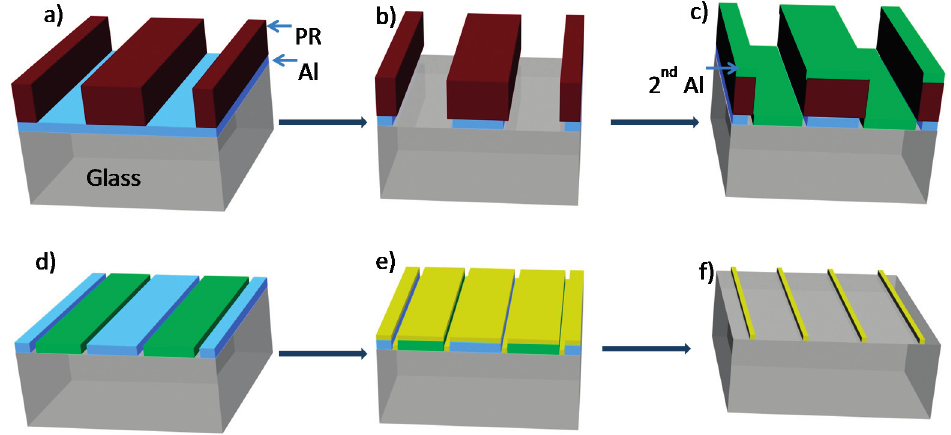
Figure 1. “Edge-patterning” of a thin aluminum film to realize nano- and micron-sized gap and wires. The process starts via photoresist (PR) patterning ( a ); isotropic etch to realize Al undercut ( b ); evaporation of a 2nd Al layer ( c ); followed by photoresist lift-off to realize nano- and micron-sized gaps ( d ); Nano- and micron-sized wires are subsequently formed by depositing a higher work function metal onto the gaps ( e ); followed by aluminum lift-off ( f